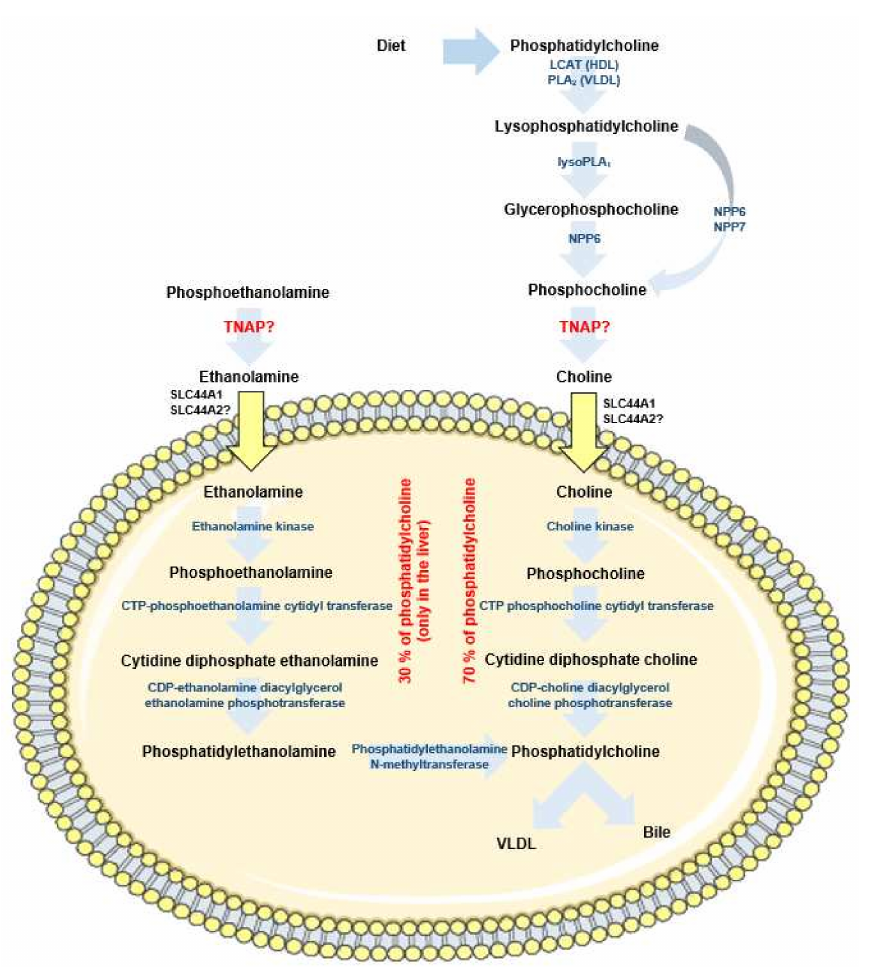
Figure 4. Sources of liver phosphatidylcholine showing the two main pathways allowing hepatocytes to produce phosphatidylcholine. On the right, phosphatidylcholine generation after the cellular uptake of choline arising from the diet or lipoproteins; on the left, generation of phosphatidyl- choline from PEA. The phosphatase(s) generating choline and ethanolamine extracellularly are not known and may include TNAP. CDP: cytidine diphosphate; CTP: cytidine triphosphate; LCAT; lecithin cholesterol acyltransferase; NPP: nucleotide pyrophosphatase/phosphodiesterases PLA 2 ; phospholipase A 2